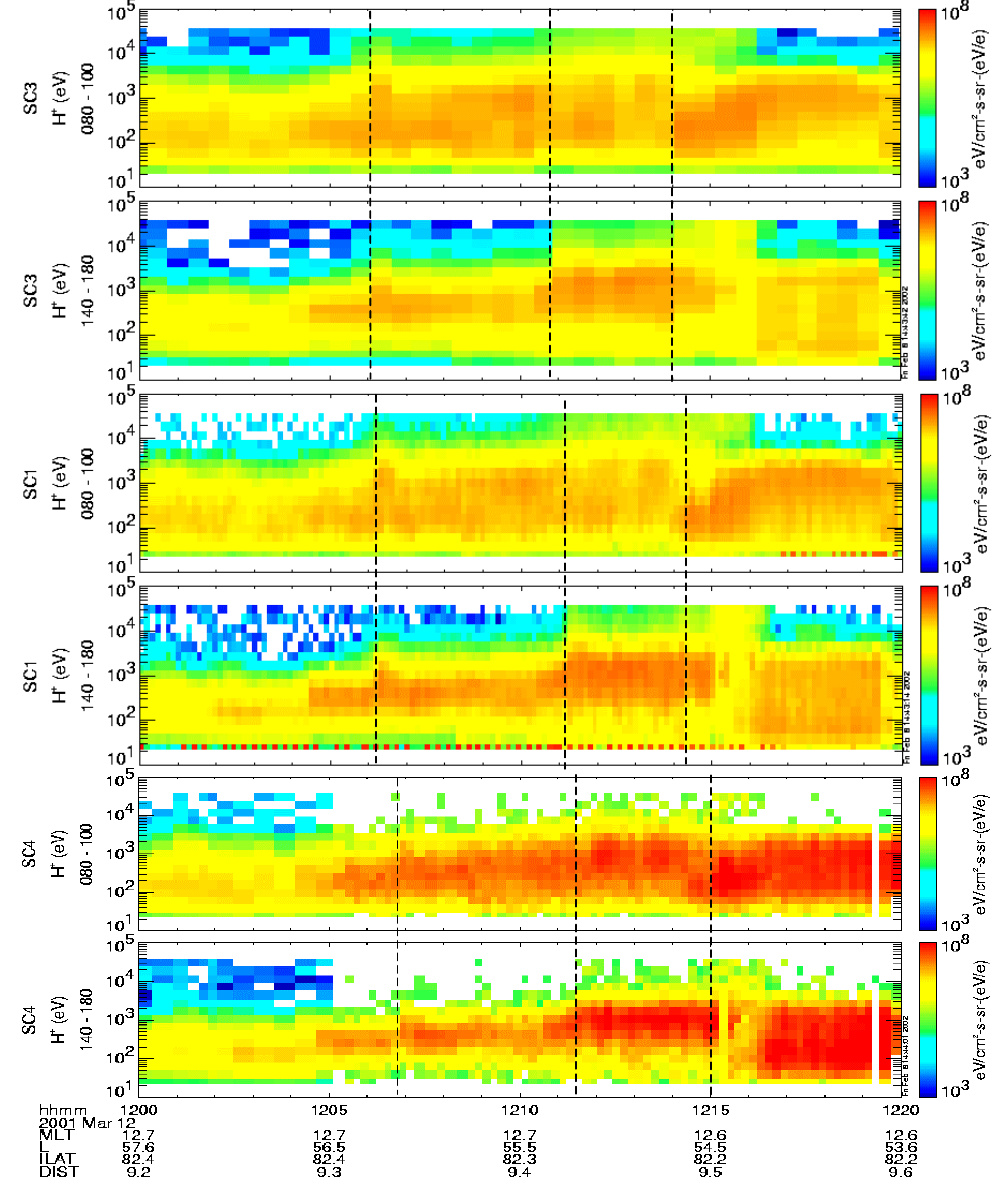
Fig. 12. Ion energy spectrograms measured by the CIS instruments on Clusters 1,3 and 4. Antiparallel and perpendicular fluxes are shown for each spacecraft. Cluster 3 is shown first as it is the lead spacecraft (see Fig.